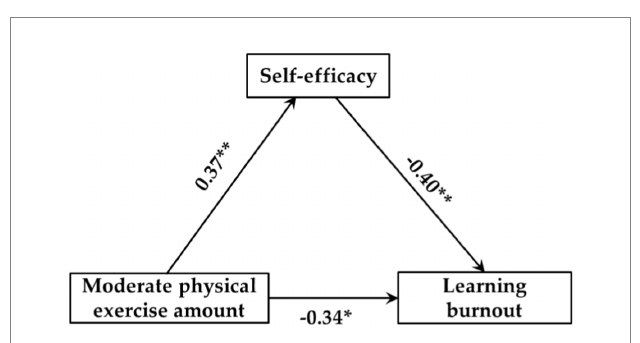
FIGURE 3 Mediating model of self-efficacy between moderate exercise amount and learning burnout.